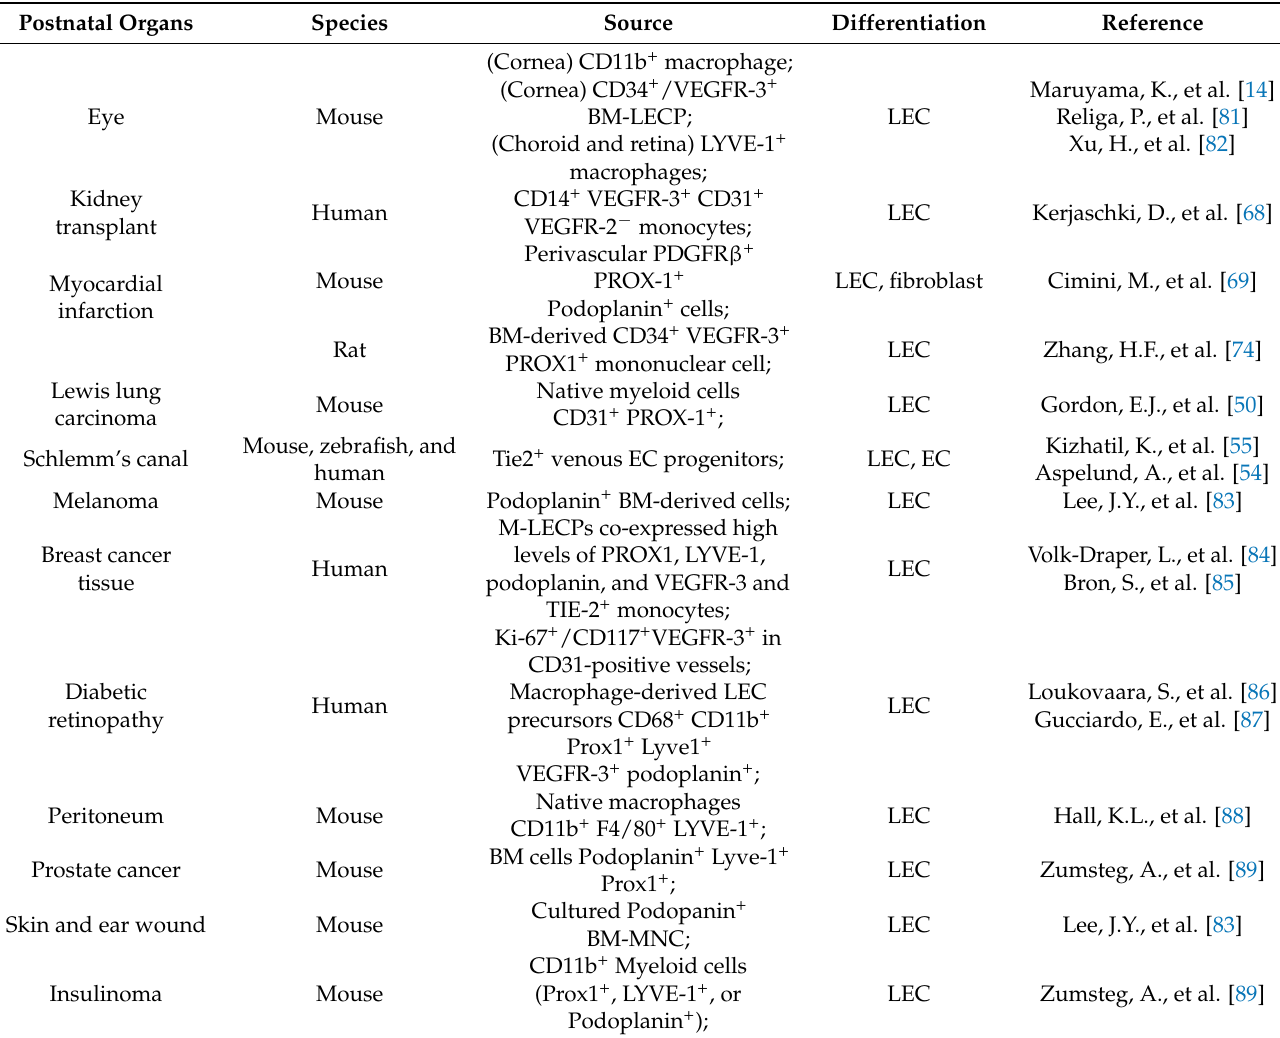
Table 1. Recent findings about tissue-specific lymphatic progenitor